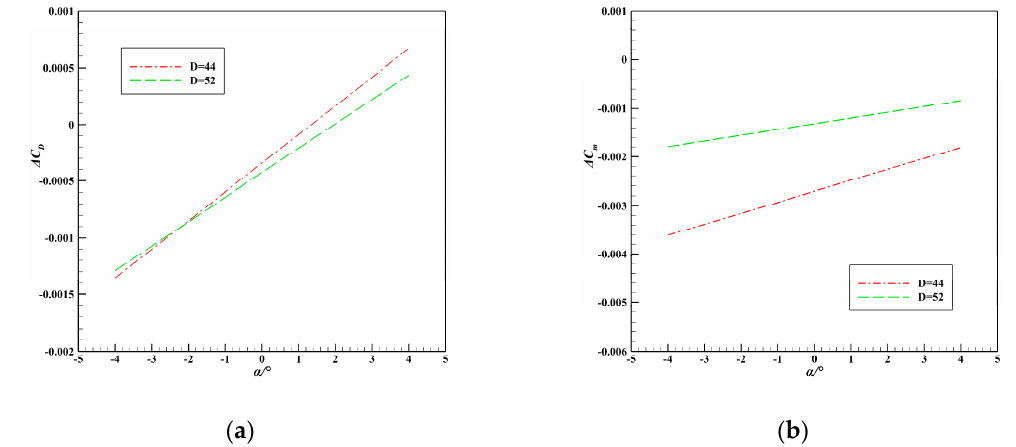
Figure 17. Support interference test results of the BWB aircraft with different straight-section diameters (D = 44 mm/52 mm, Ma = 0.75): ( a ) Δ C D - α curves; ( b ) Δ C m - α curves.